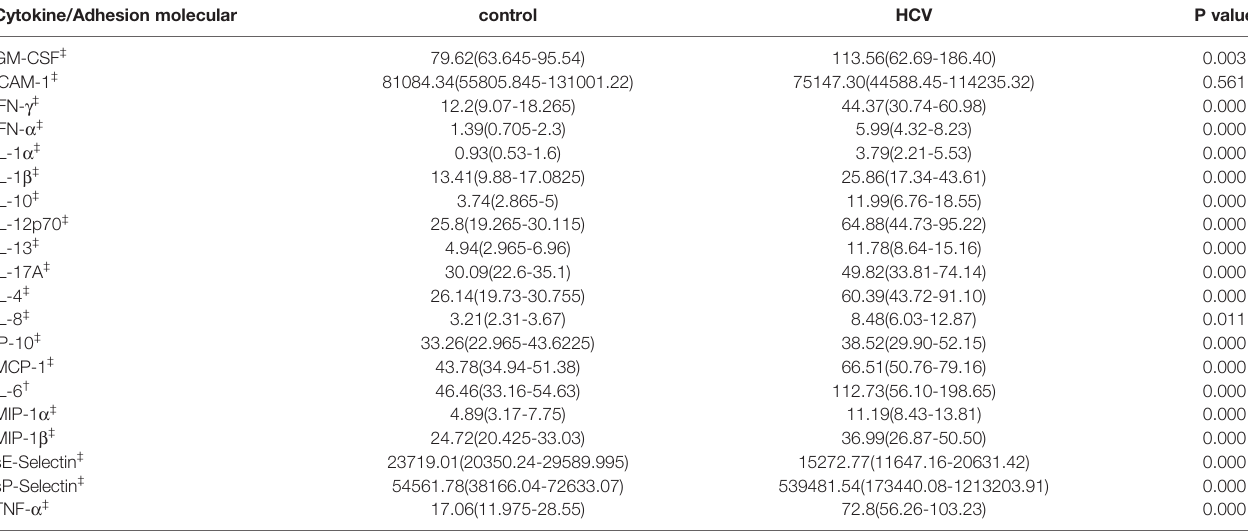
TABLE 3 | Concentrations (pg/ml) of different plasma cytokines in controls and HCV patients. Cytokine/Adhesion molecular